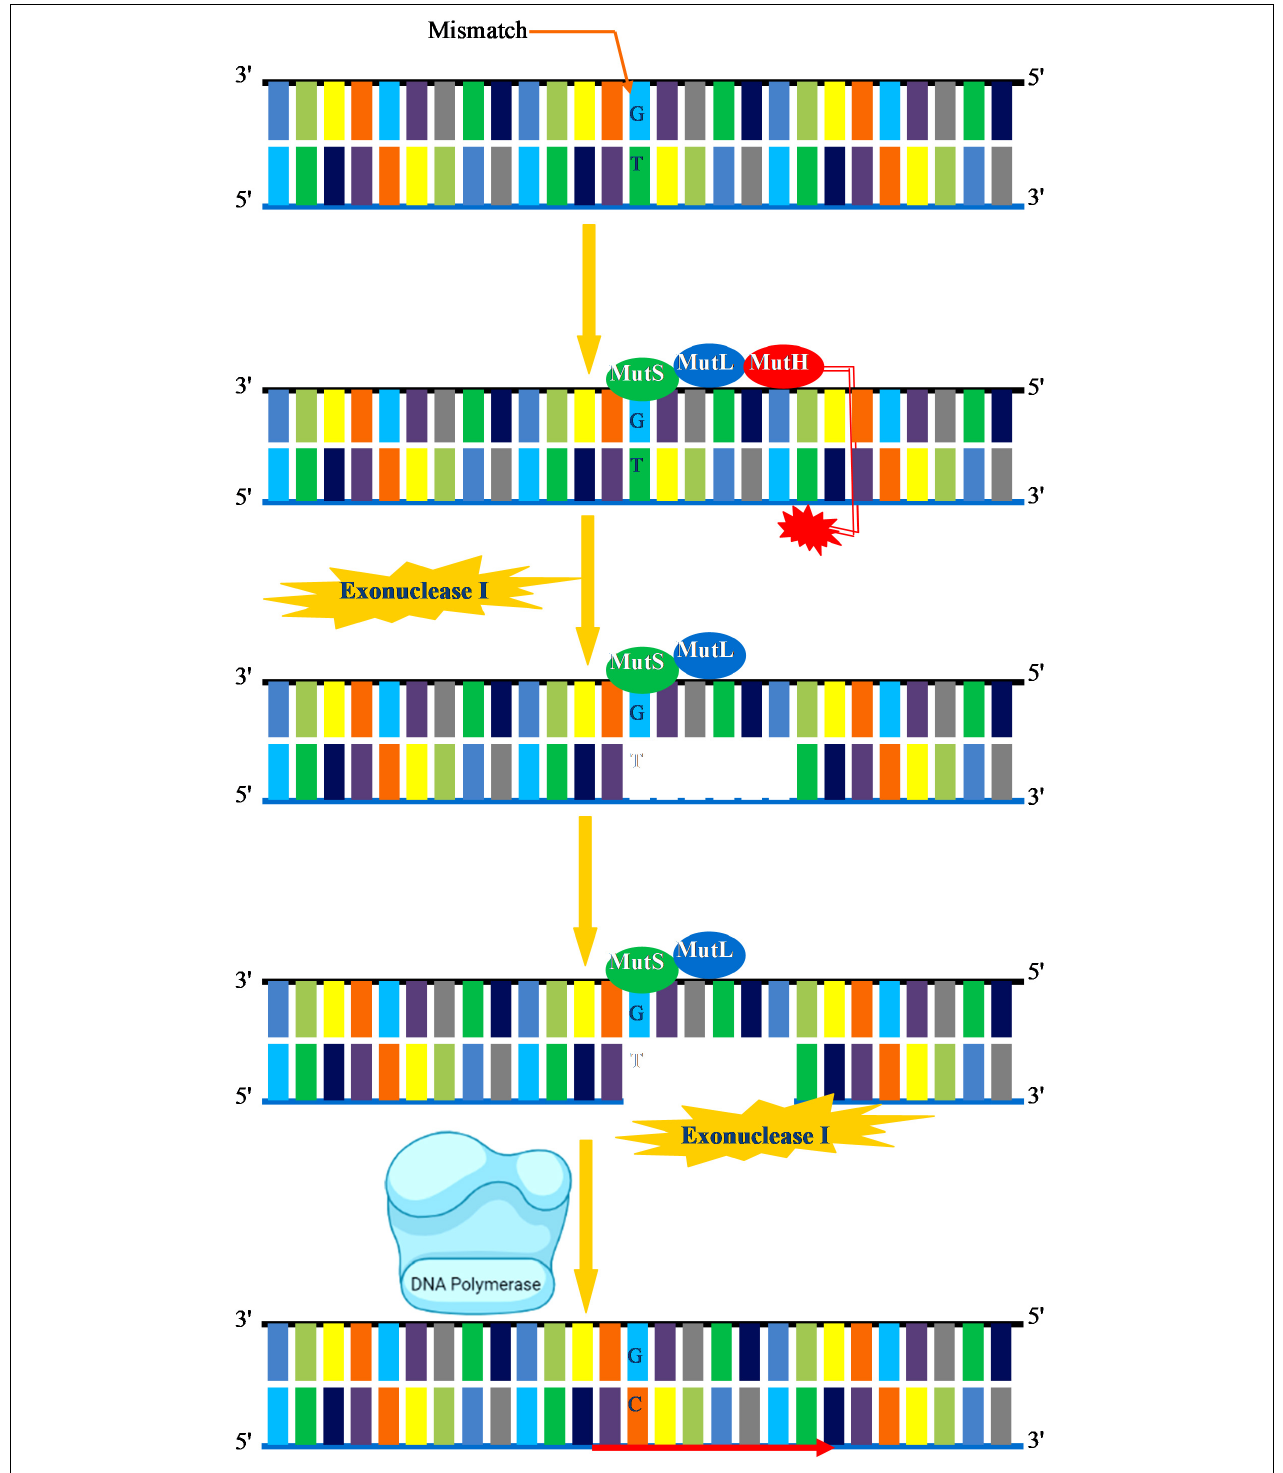
FIGURE 4 | Mismatch repair. A G-T mismatch is recognized by MutS in association with MutL. MutH cleaves in the vicinity of mismatch. Exonuclease I initiates removal of DNA segment containing the incorrect base DNA. Exonuclease I completes the removal of damaged DNA. DNA polymerase III then synthesizes the new DNA and fills the